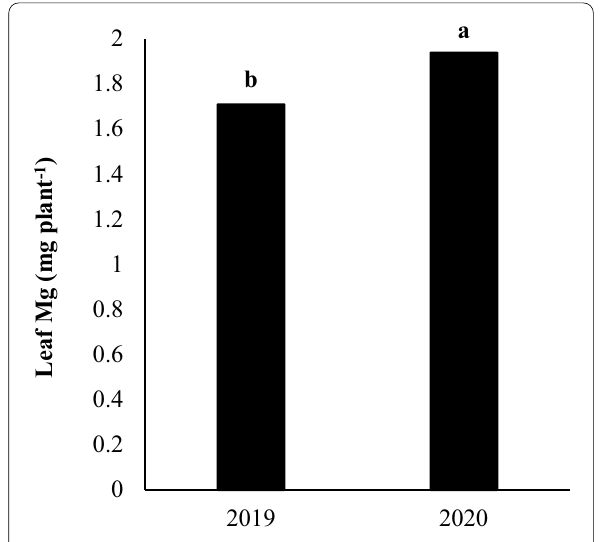
Fig. 7 The effect of year on content of leaf